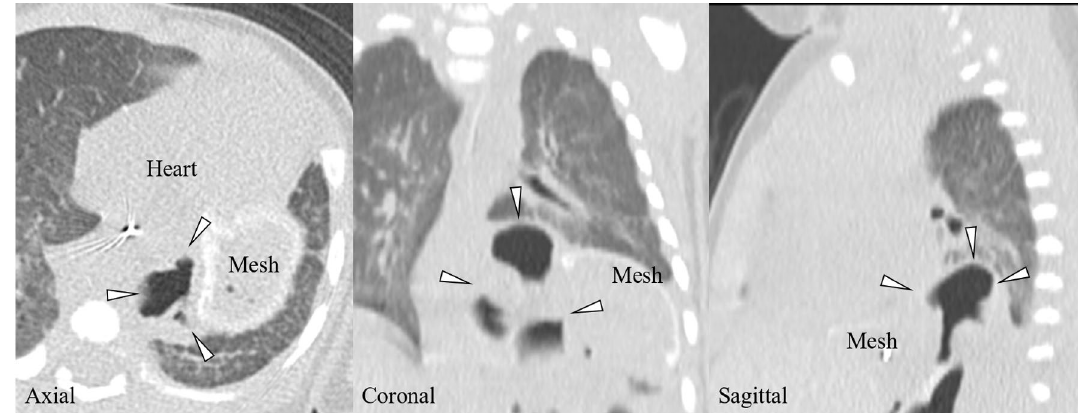
Fig. 3 Computed tomography in case 1. Computed tomography shows intestine or colon is prolapsed into the thoracic cavity at the medial side of artificial mesh